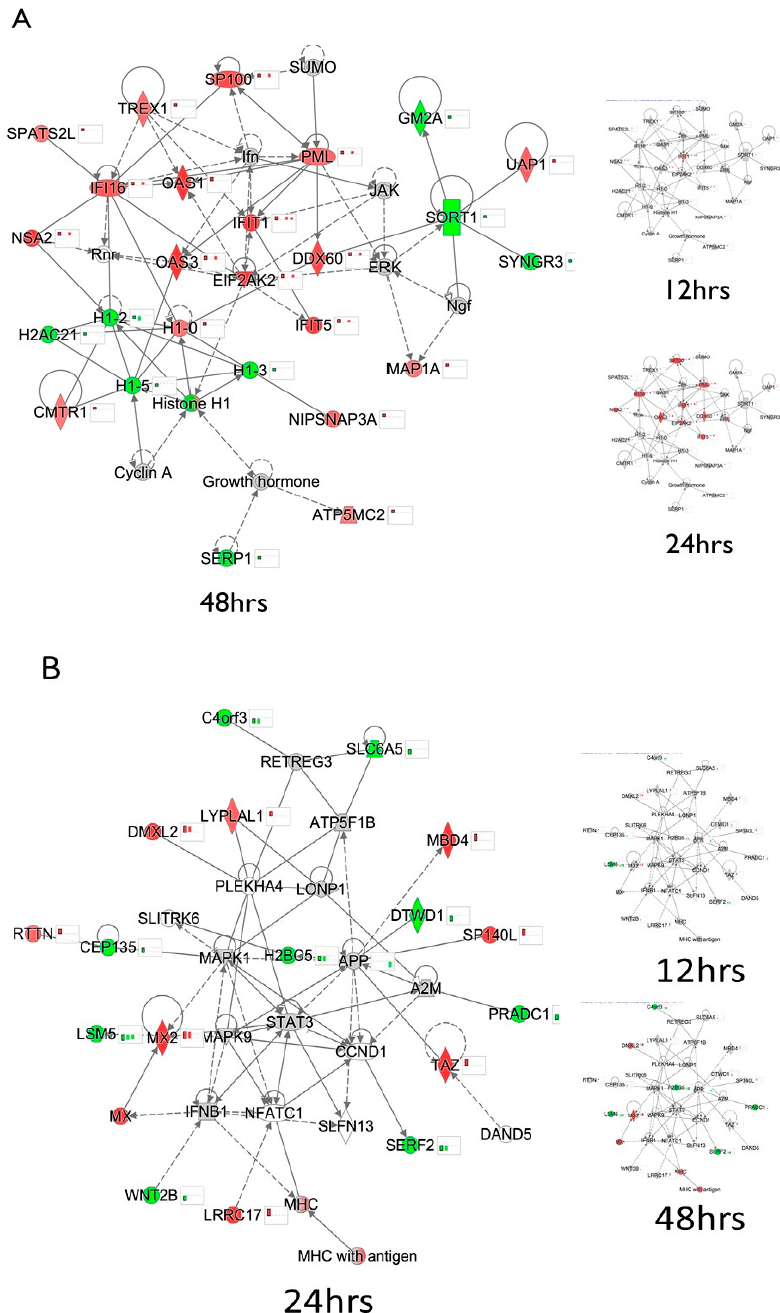
Figure 2. Top dysregulated cellular networks in ZIKV-infected U251 cells at 24 and 48 hpi, respec- tively, based on the list of statistically significantly dysregulated proteins ( A ) , Top dysregulated cellular network in ZIKV-infected U251 cells at 48 hpi is Antimicrobial Response, cell signaling and infectious diseases. Overlaid 12 and 24 hpi data shown in smaller diagrams. ( B ), Top dysregulated cellular network in ZIKV-infected U251 cells at 24 hpi is Cell Death and survival, connective tissue development and function and energy production network. Overlaid 12 and 48 hpi data shown in smaller diagrams. Green represents U251 proteins that were significantly under-expressed compared to their time-matched mock-infected values while red represents proteins that were significantly over-expressed compared to their time-matched mock-infected samples. 2-tailed Students t -test and Z-score analyses were used to determine the statistical significance.